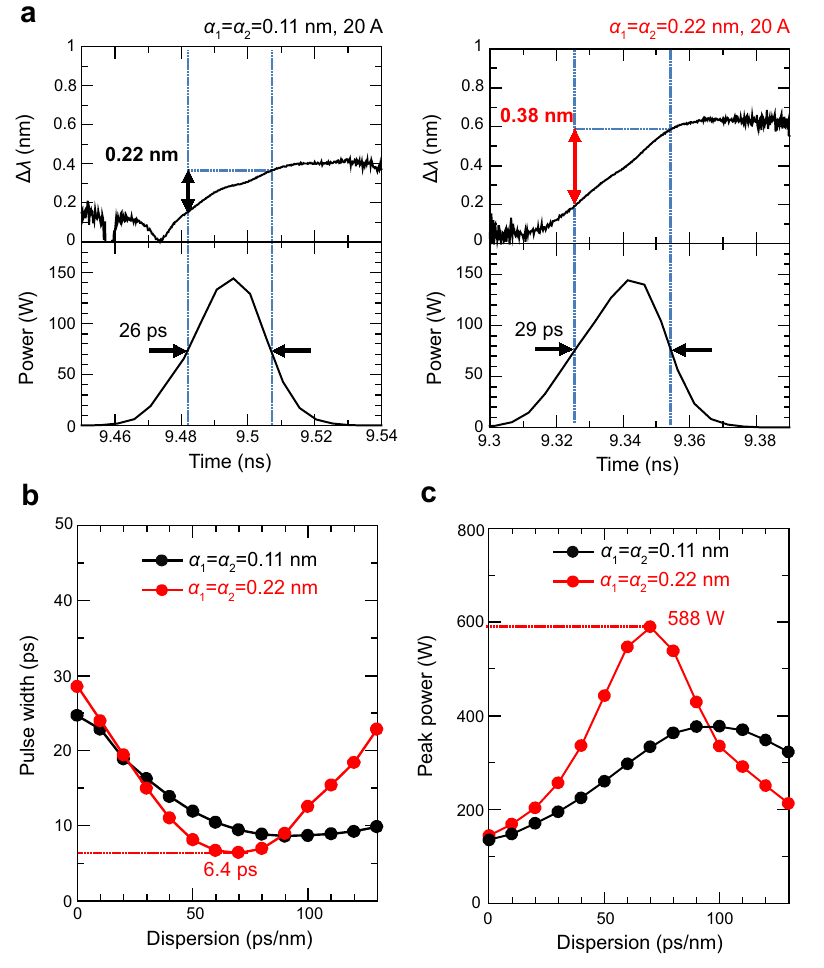
Fig. 4 | Spontaneous wavelength chirping and pulse compression of self- evolvingphotoniccrystals.a Calculatedinstantaneouswavelengthchangeduring each pulsation in two self-evolving photonic crystals with different gradient para- meters( α 1 = α 2 =0.11nm and α 1 = α 2 =0.22nm).The value of β is fi xed to 0.11nm in